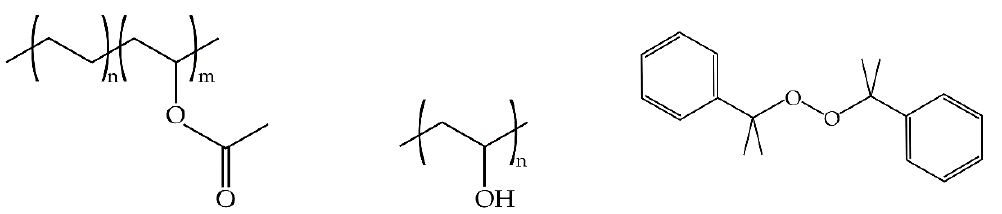
Figure1. Representationofthechemicalstructureofdifferentcompatibilizersusedinpolylactide / biobased high-density polyethylene (PLA / bioPE) immiscible Figure 1. Representation of the chemical structure of different compatibilizers used in polylactide/biobased high-density polyethylene (PLA/bioPE) immiscible blends.